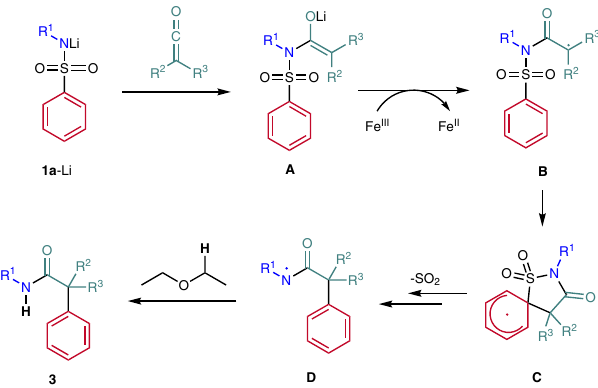
Fig. 6 Plausible mechanism of the polar-radical crossover cascade. The reaction proceeds through anionic ( 1a-Li and A ) and radical intermediates ( B , C and D